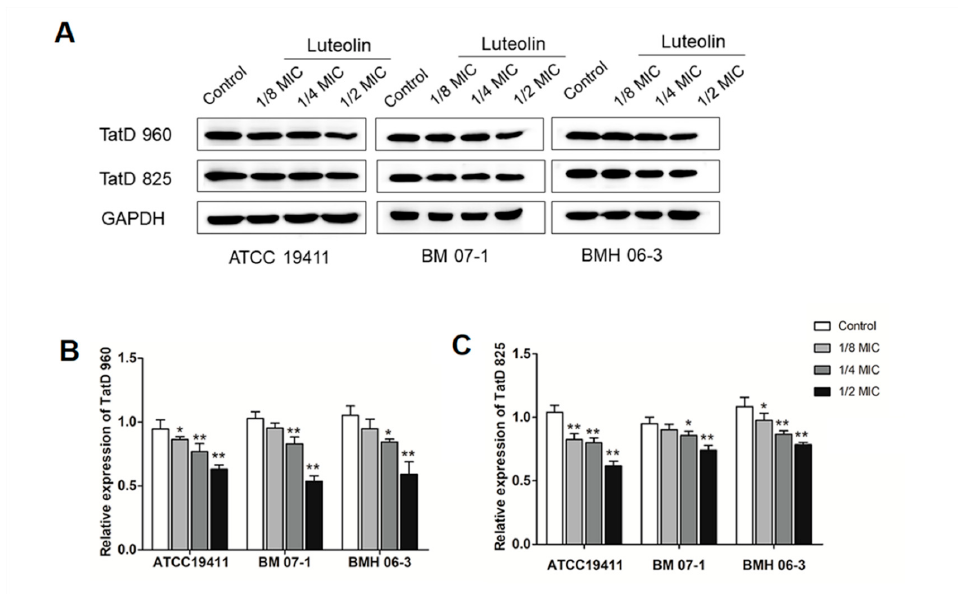
Figure 4. Luteolin led to a decrease in the expression of TatD DNases. ( A ) Western blot results of TatD DNases in T . pyogenes (ATCC19411, BM07-1, and BMH06-3) with different treatment, ( B ) the expression of TatD960, ( C ) the expression of TatD825. The concentrations of luteolin were 0, 1/8, 1/4, and 1/2 MIC, respectively. Data were presented as means ± SD. (* compared with control, * p < 0.05, ** p < 0.01).